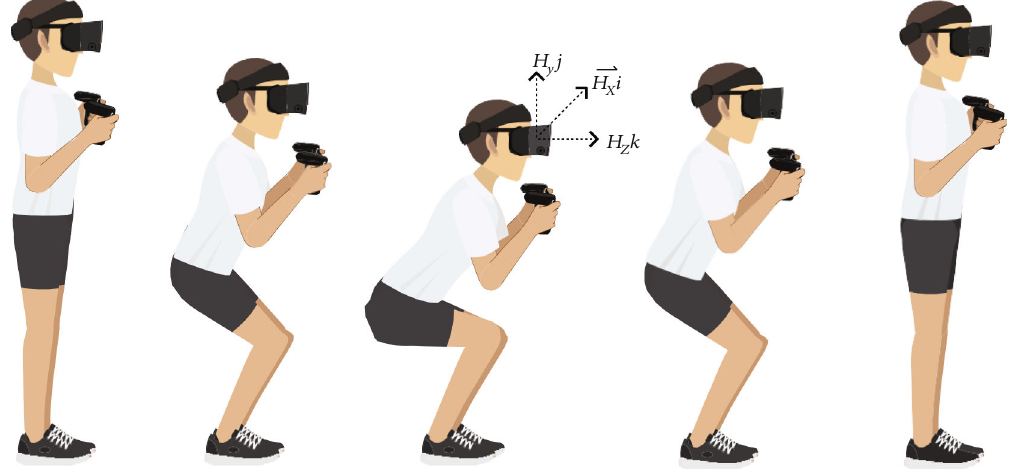
Figure 3: Virtual running with the Squat